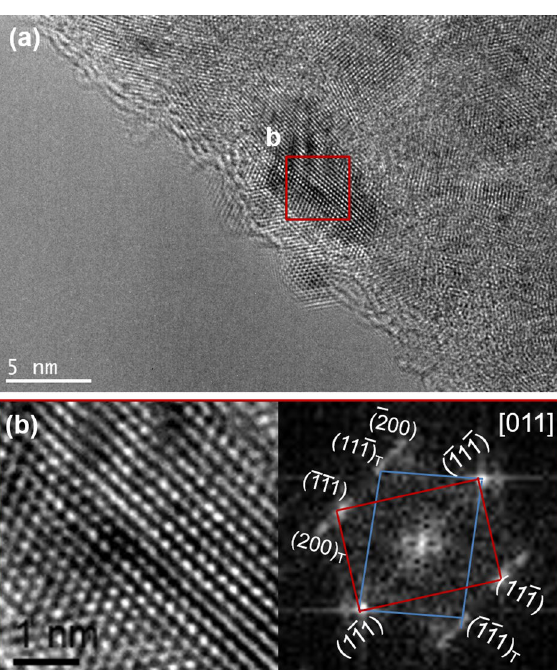
Figure 3. High resolution TEM images of Co–Cu–Fe–Ni–Zn HEA thin films nanocrystalline structure projected for the three principal zone axes of an FCC/BCC phase. ( a , d and g ) BF-TEM on-axis image of a fine grain size is shown in red boxes. ( b , e and h ) Illustration of lattice image contains easily interpreted d spacing information. ( c , f and i ) FFTs taken from image ( c , f and i ) indexed for BCC/FCC crystals in the beam directions of [001], [110] and [ 1 11]. Ratios of inter-spacing and the angles are well matched with standard BCC ( c and i ) and FCC ( c , f and i ) diffraction patterns.